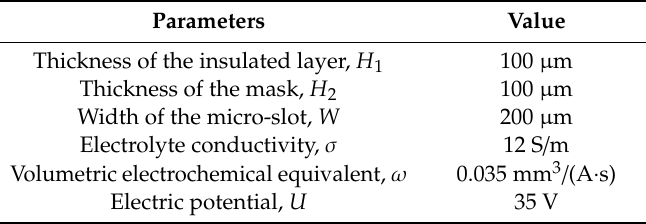
Table 1. The parameters set for the